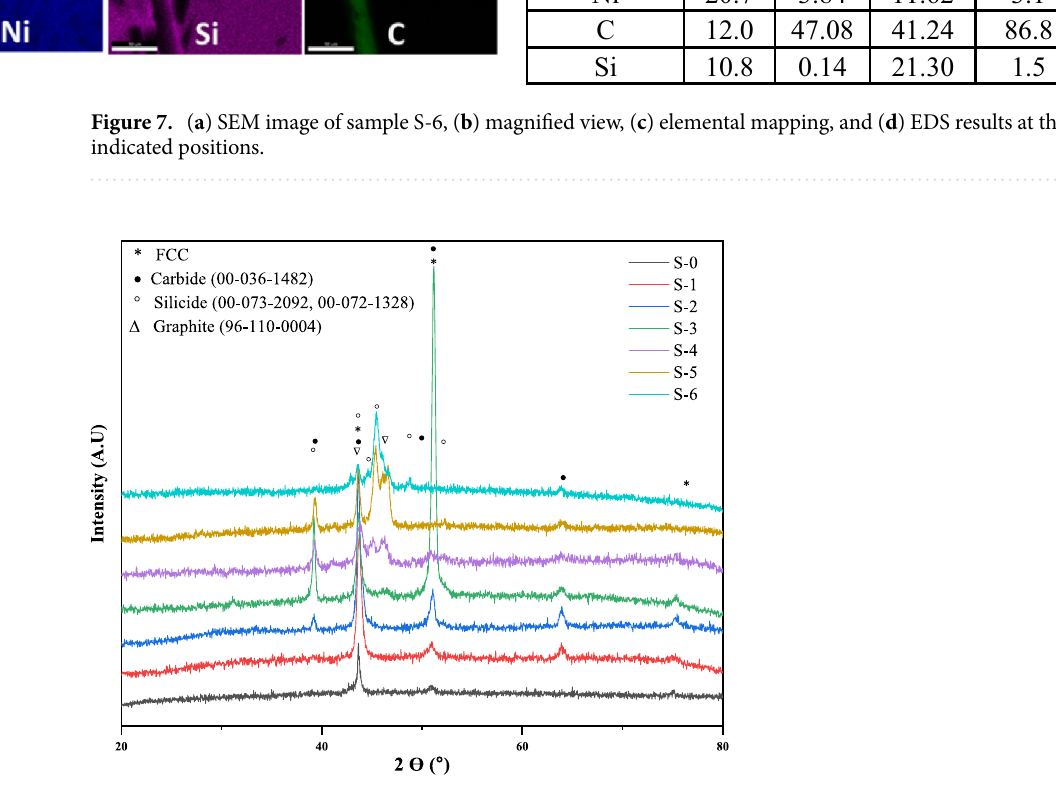
Figure 8. XRD patterns of the as-developed high entropy alloy